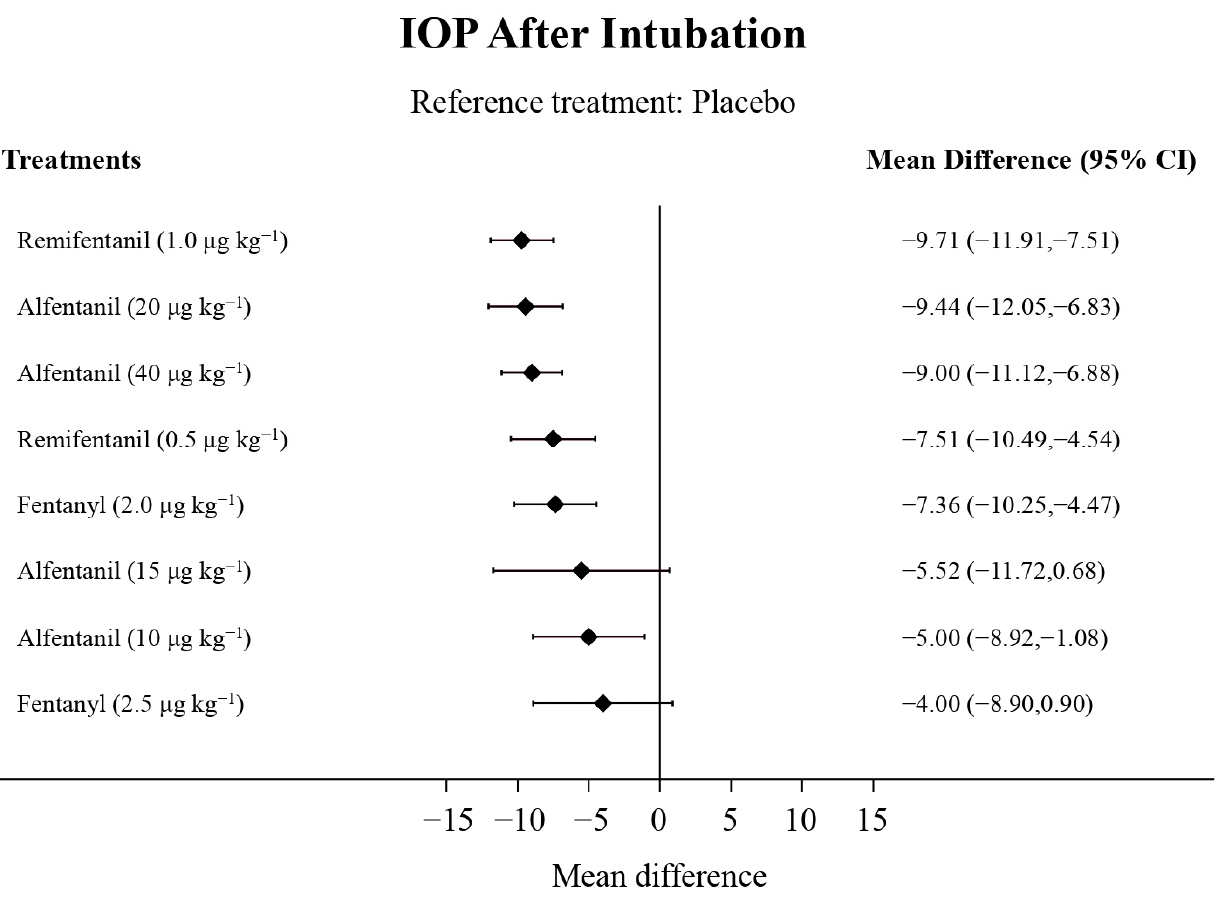
Figure 3. The forest plot depicts the effects of each treatment on the intraocular pressure measured after endotracheal intubation relative to the placebo. Table 2. The comparative efficacy of treatments on the intraocular pressure measured after endotra- cheal